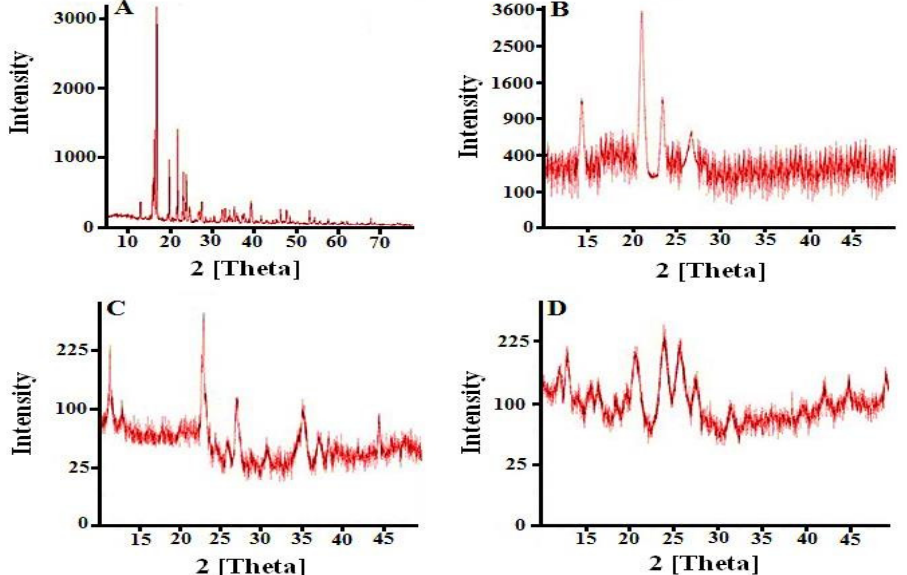
Figure 5. XRD diffractograms of ( A ) cytarabine, ( B ) Na-CMC, ( C ) pectin, and ( D ) prepared hy- drogel .